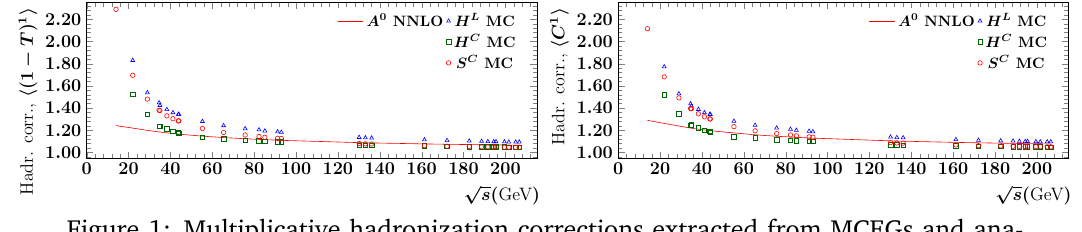
Figure 1: Multiplicative hadronization corrections extracted from MCEGs and ana- lytic ( A scheme) hadronization models [ 4 ] . Figures from Ref. [ 4 ] . 0